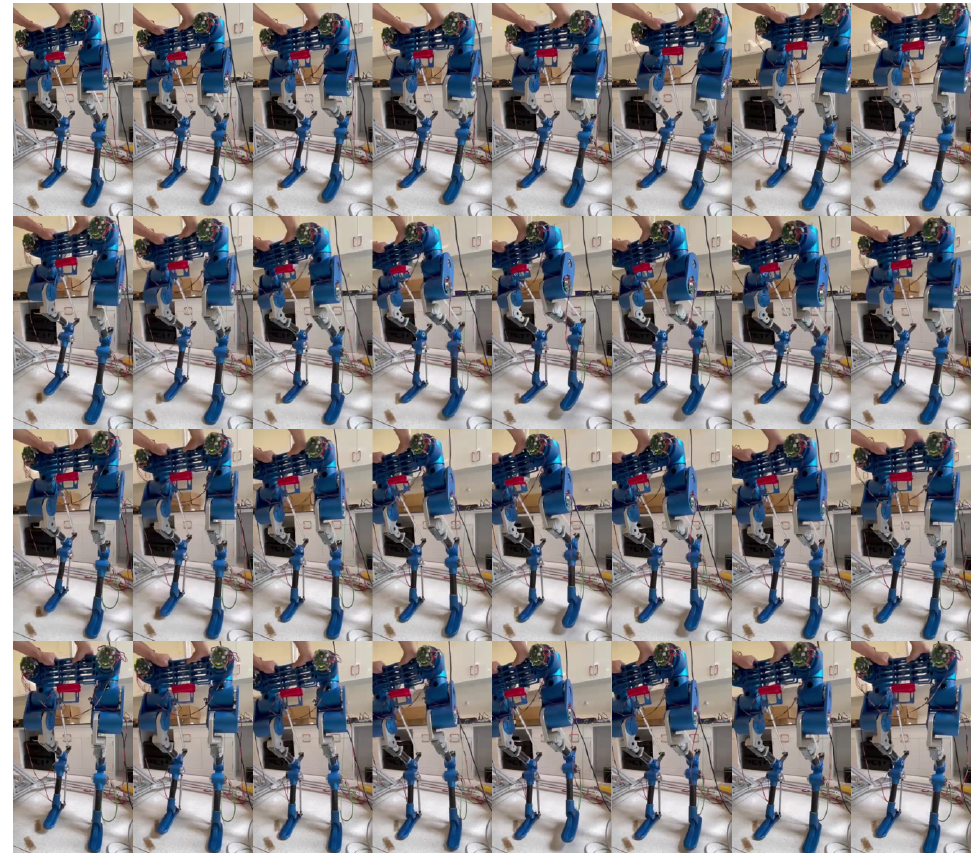
Figure 12. The prototype walks step on flat